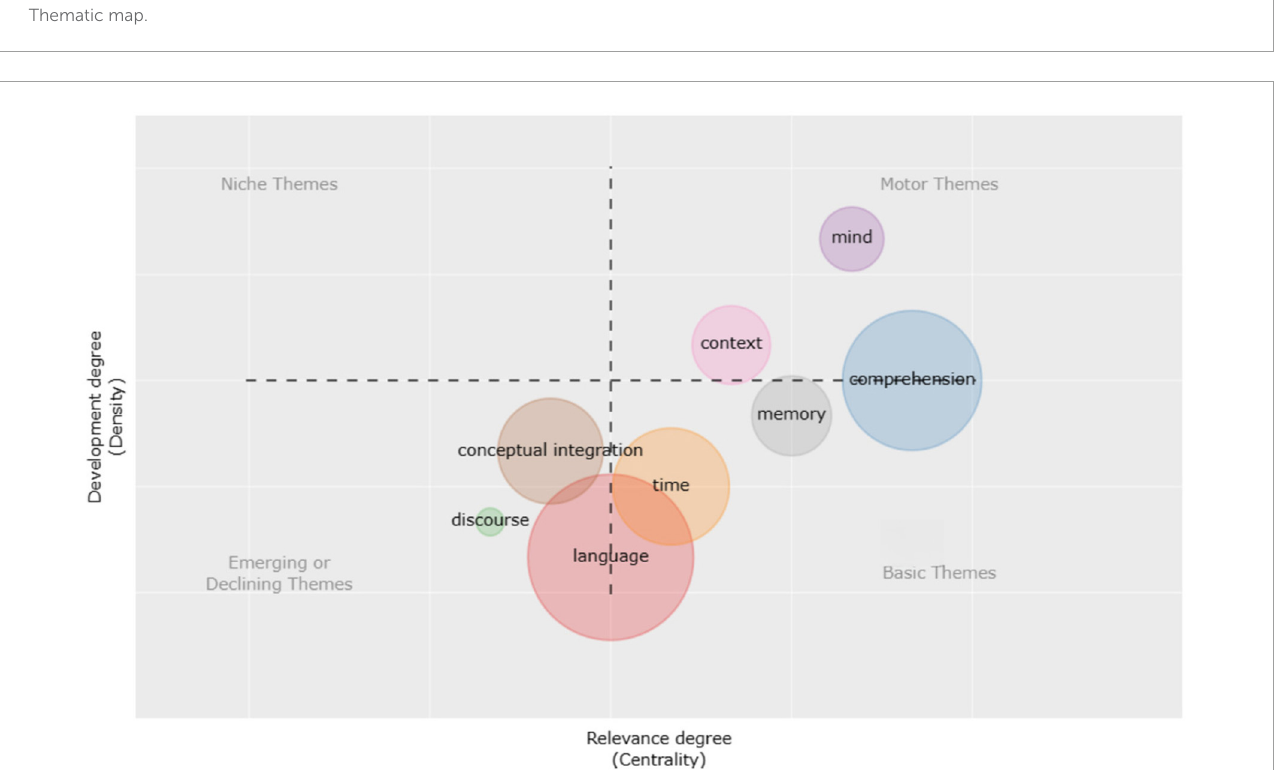
FIGURE7 Time slice 1: thematic evolution during